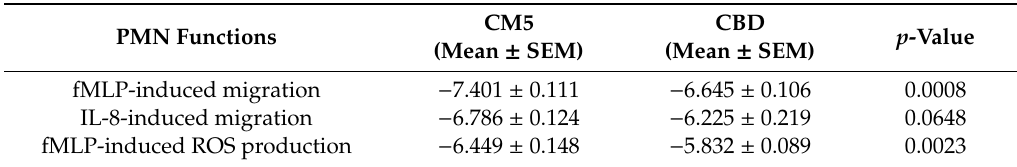
Table 1. IC 50 values of the Log concentration–response curves of CM5 and CBD on PMN functions. Data are expressed as log (M) of